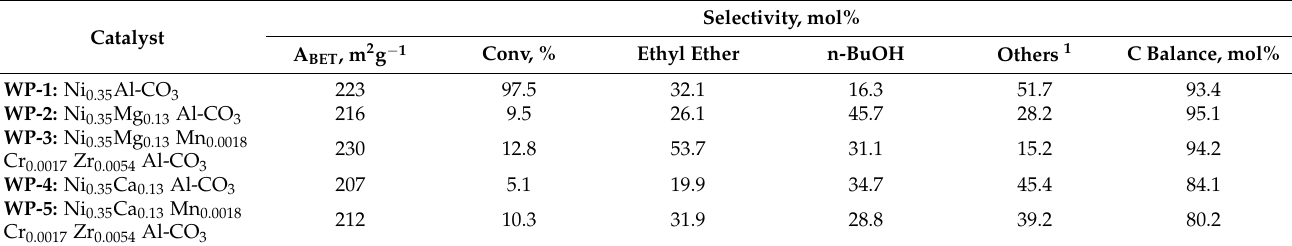
Figure 4. Raman spectra of the ( A ) calcined and ( B ) after-reaction WP catalysts. Table 3. The physicochemical characterization and activity data.